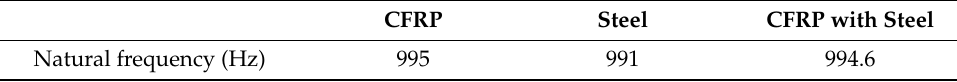
Figure 8. Natural frequency of the chuck adapter. ( a ) CFRP, ( b ) steel, ( c ) CFRP with steel. Table 6. Experimental results of three types of chuck adapters.